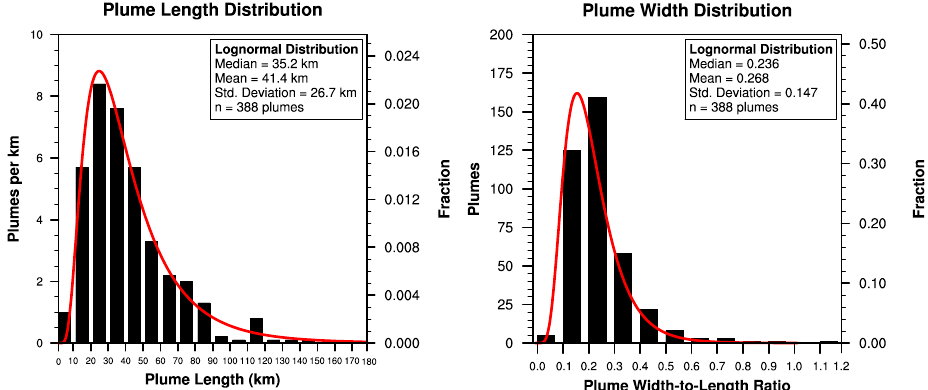
Fig. 3. Histogram of (a) length and (b) width-to-length ratio with best-fit lognormal distributions overlaid (red curves). Both plots omit 2 plumes included in the analysis.